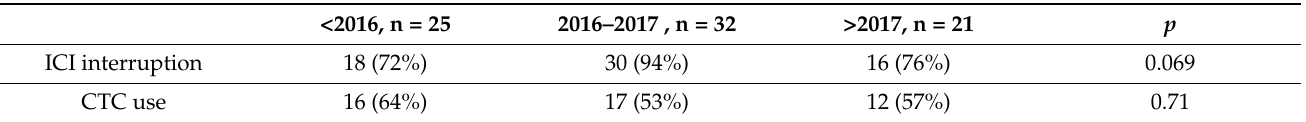
Table 4. Management of irAEs over time. irAEs = immune related Adverse Events; CTC = glucocorticoids; ICI = immune check-point